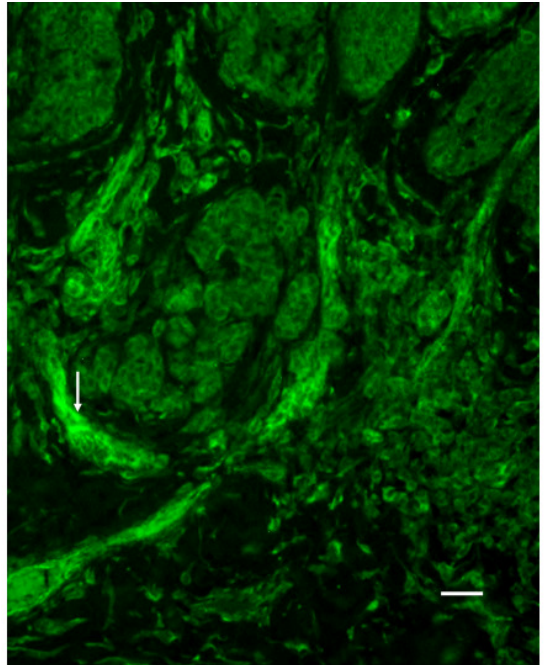
Figure 2. Immunostaining for 5-HT2AR in the vessels (arrow) of SSM tissue. Bar is 20 µ